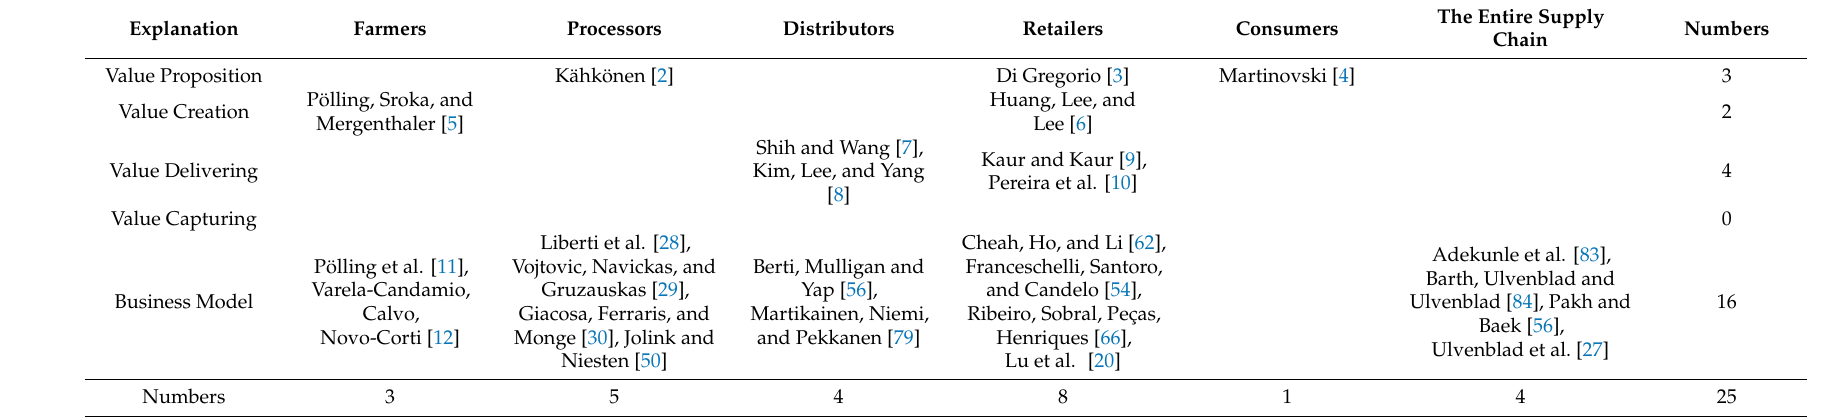
Table 4. Business model innovation and supply chain and business model